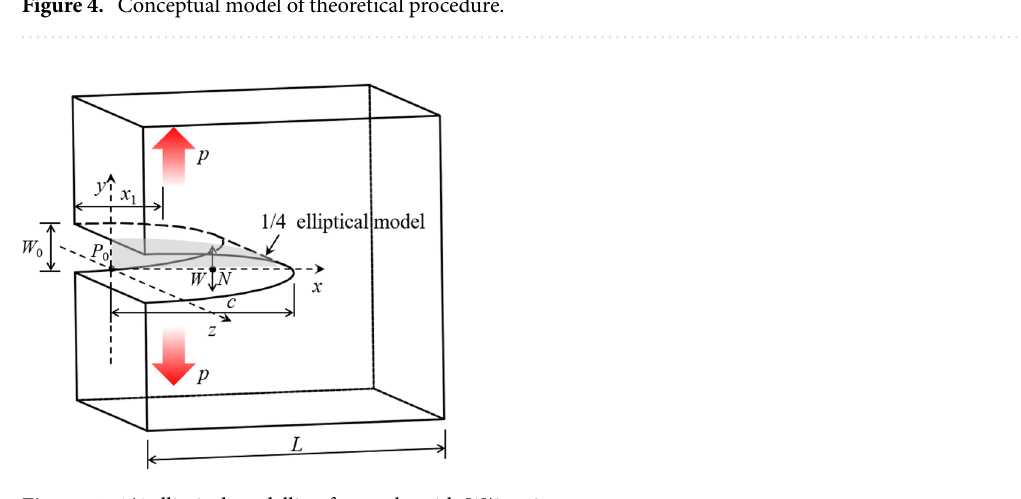
Figure 5. 1/4 elliptical modelling for cracks with W /2 →